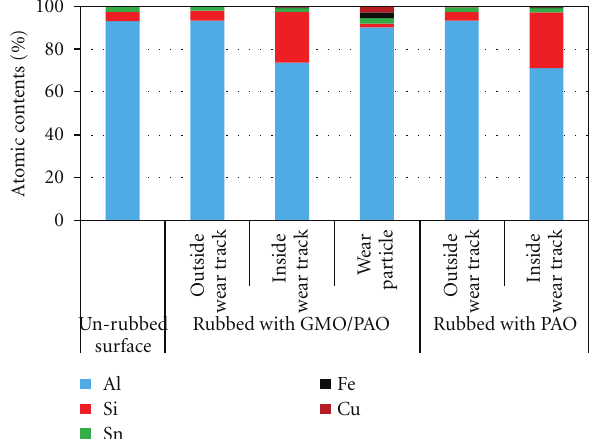
Figure 6: Concentration of elements on surface obtained by SEM- EDX analysis.